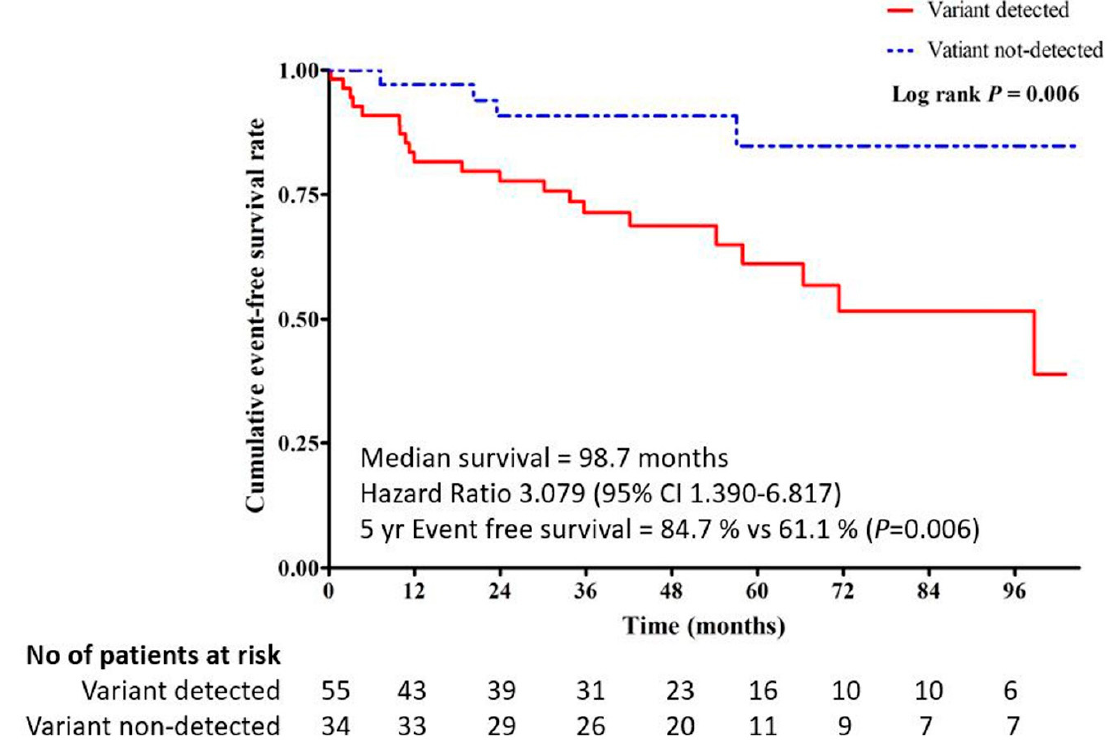
Figure 4. Cumulative event-free survival curves stratified by the variant detected or not-detected groups: Event-free survival was significantly different between the two groups ( p = 0.006). CI: confidence interval. Table 5. Major adverse cardiac and cerebrovascular events and interventions during follow-up.